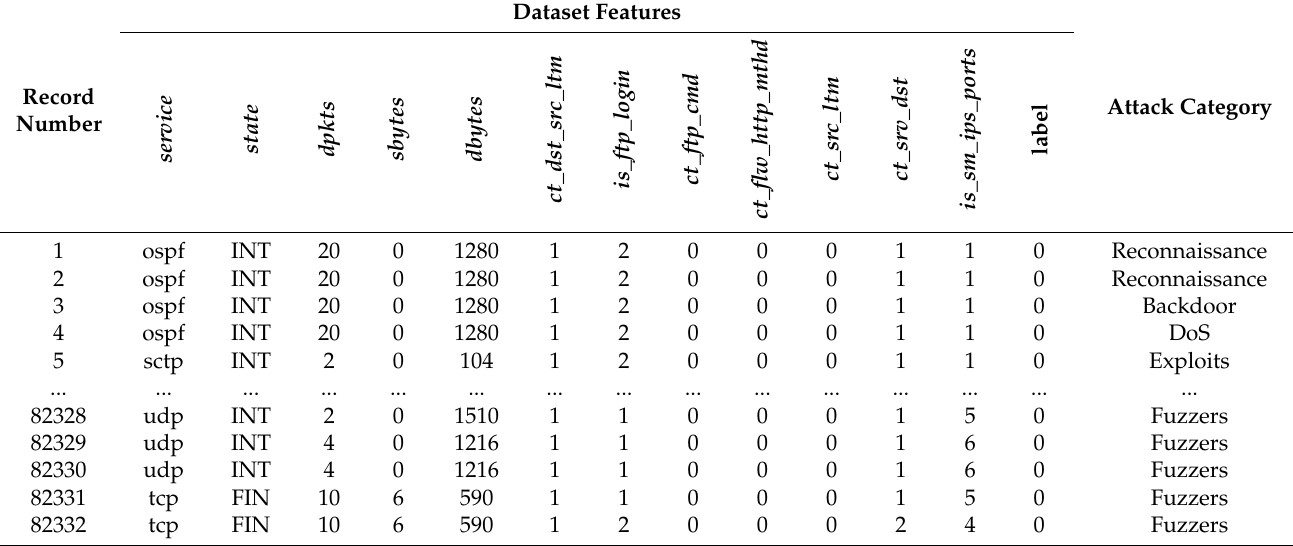
Table 2. Dataset of network traffic (a